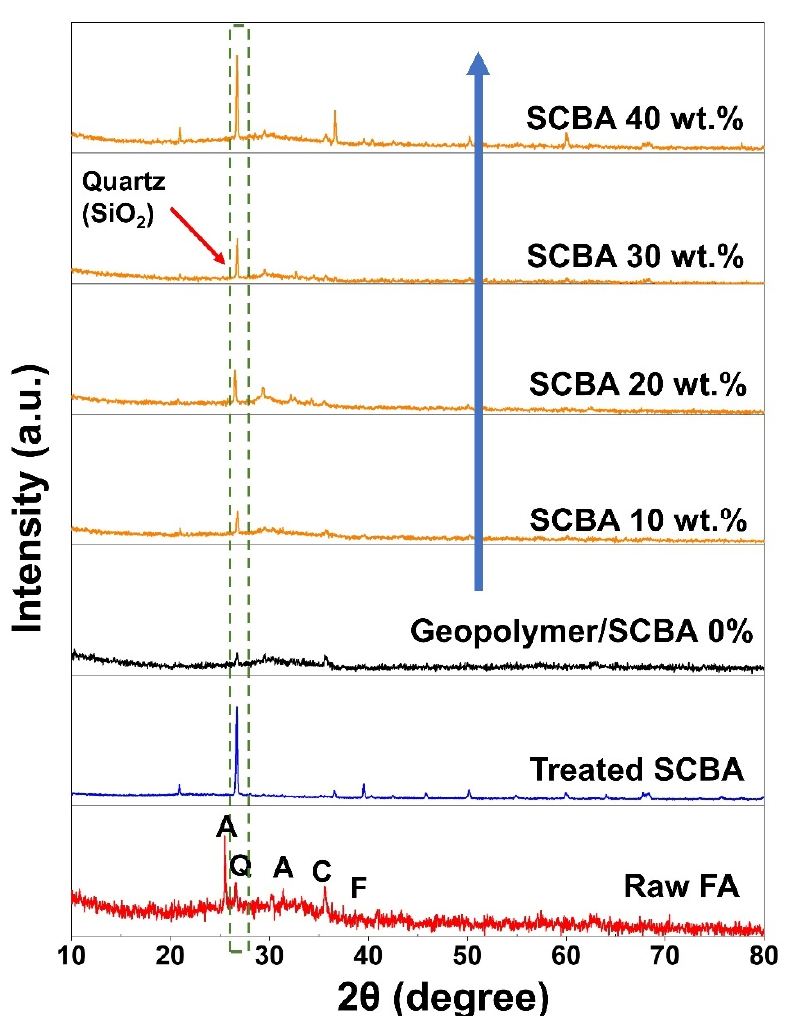
Figure 4. XRD patterns of the raw fly ash, treated SCBA, geopolymer paste, and geopolymer/SCBA composite. Denote the initial of phases: Q = quartz, A = anhydrite, C = calcium oxide, F = hematite.